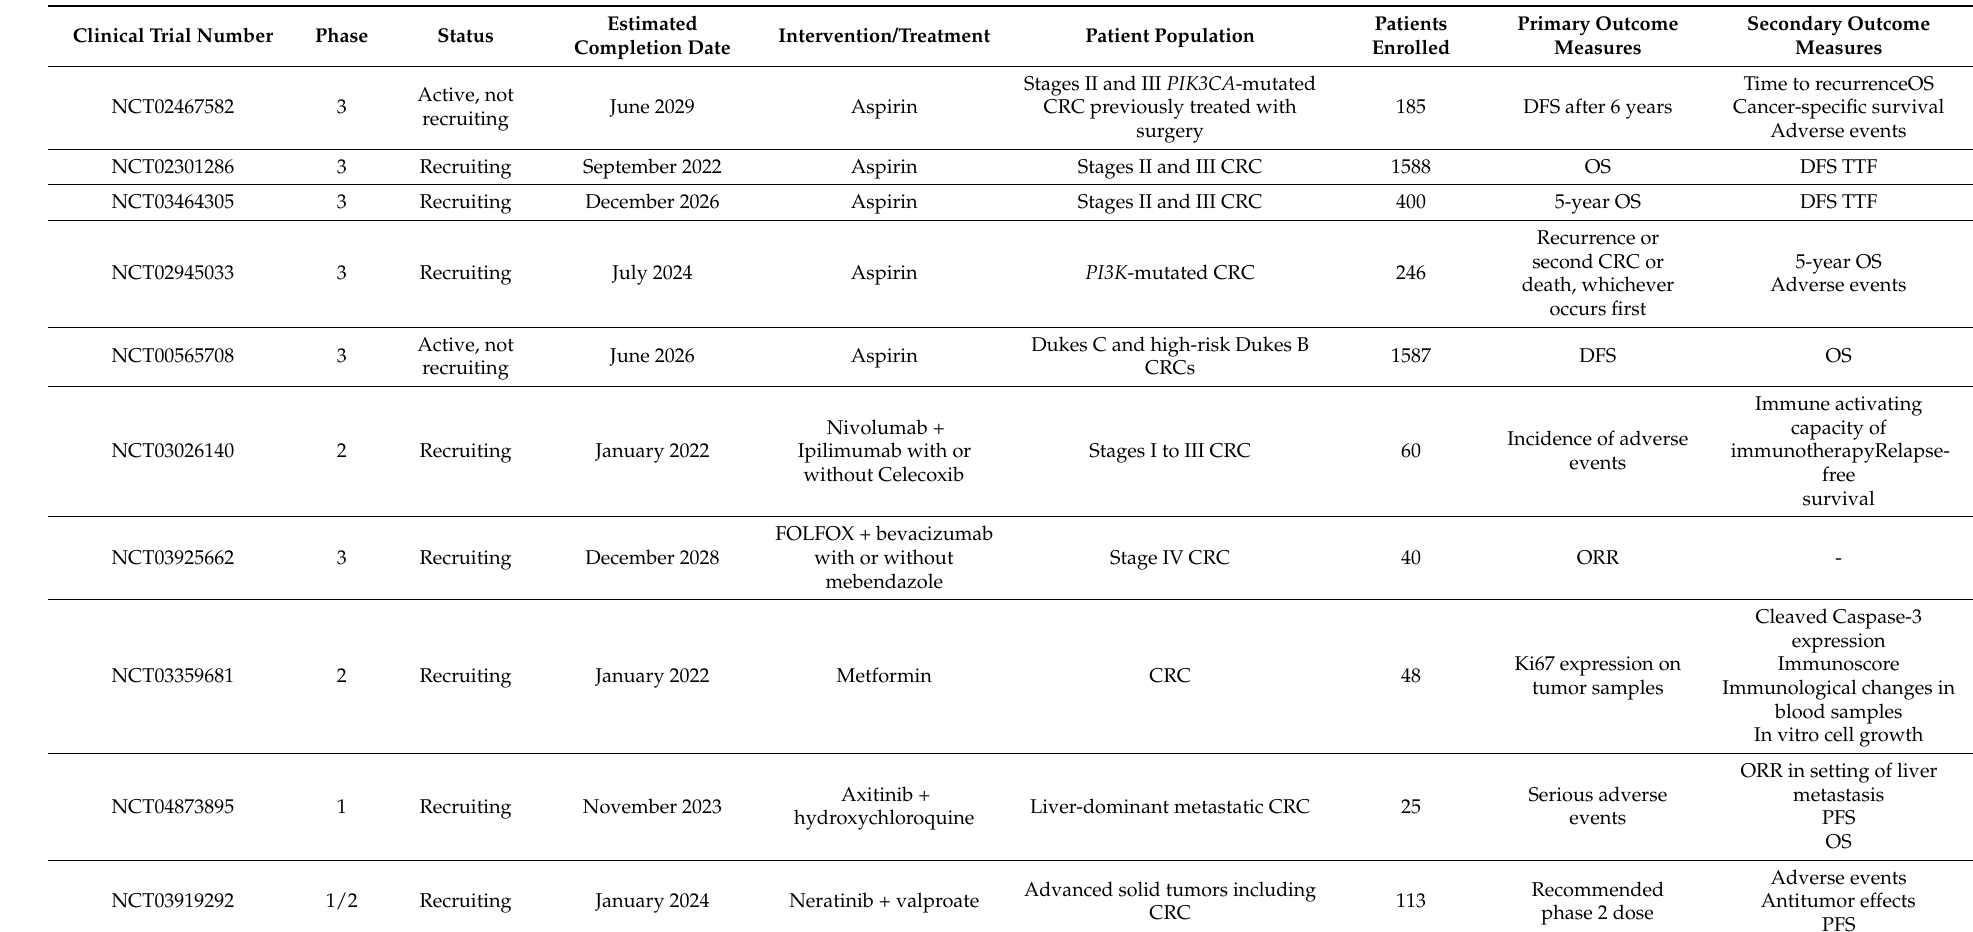
Table 2. Examples of some repurposed drugs currently being clinically investigated for the treatment of colon